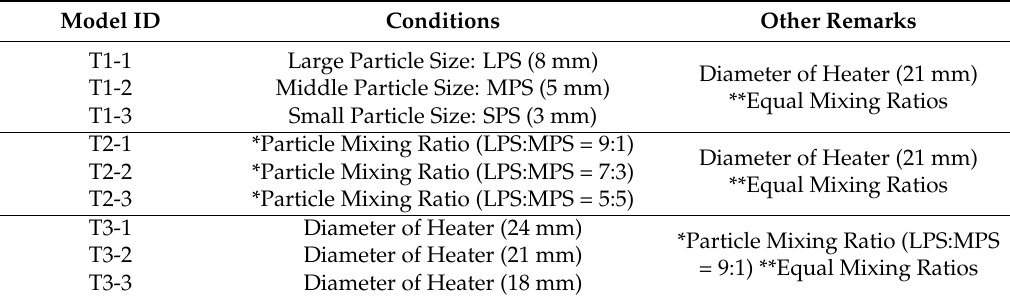
Table 1. Individual models for experimental tests